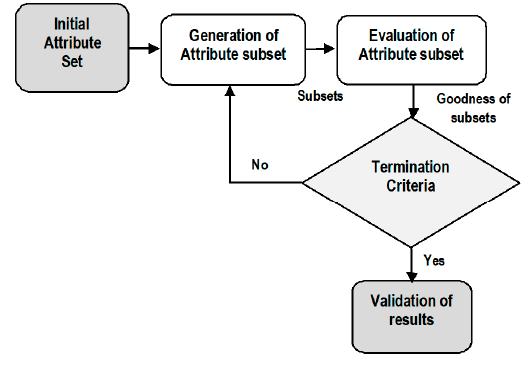
Figure 1. Attribute Selection Process.